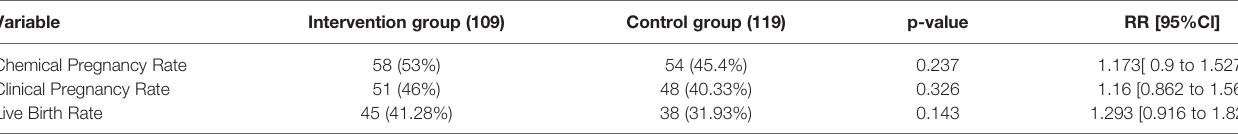
TABLE 3 | Fresh Embryo Transfer results.